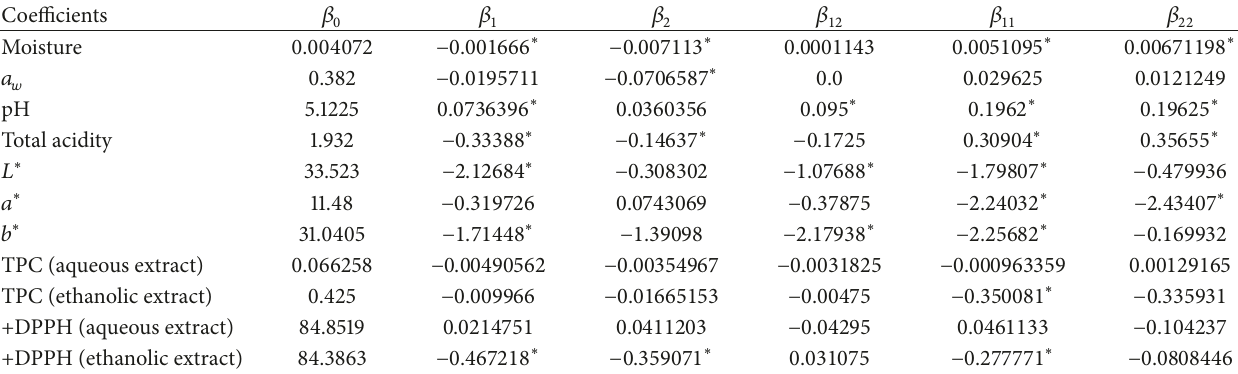
Table 4: Regression coefficients of the second-order polynomial for the response